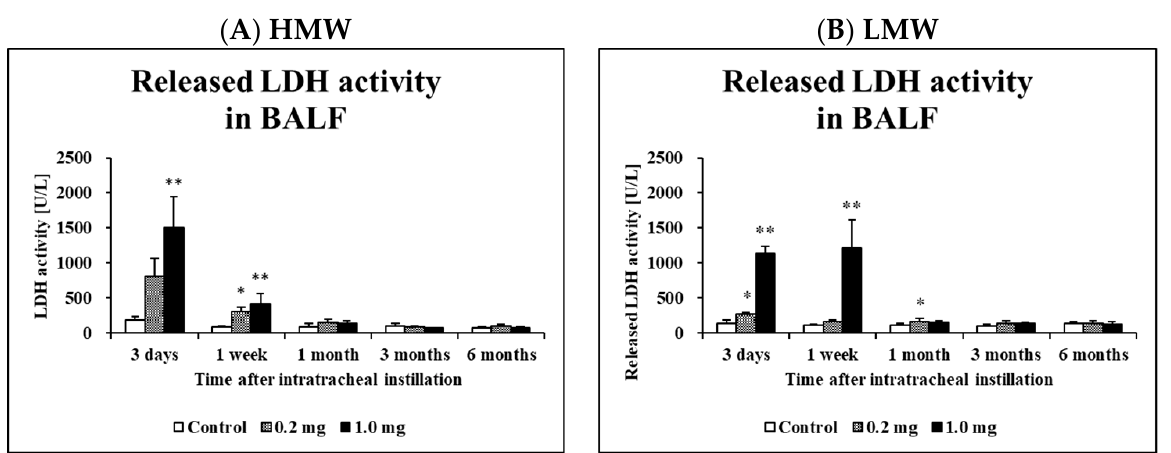
Figure 3. Analysis of released LDH activity in BALF following intratracheal instillation. ( A ) HMW PAA-exposure group and ( B ) LMW PAA-exposure group. Released LDH activity in BALF in all of the exposed groups were higher than those in the control groups in a dose dependent-manner. Data are presented as mean ± SE. (* p < 0.05, ** p < 0.01).